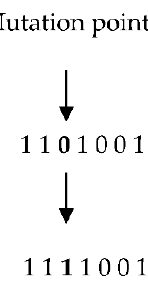
Figure A2. The scheme of a single mutation process.